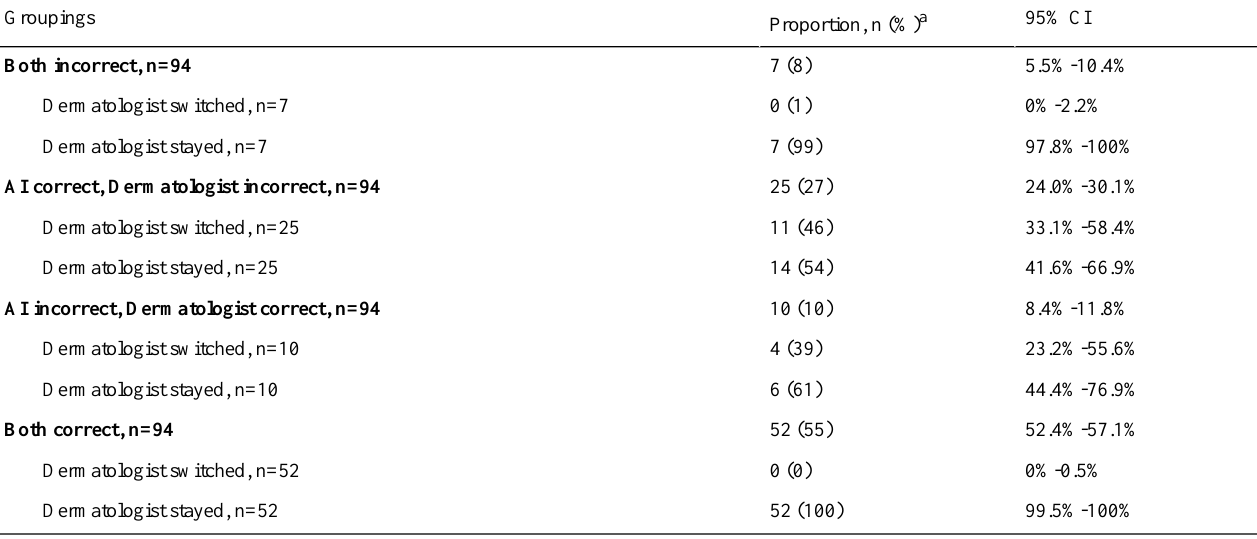
Table 2. Distribution of the correct and incorrect predictions by classifier and dermatologists without artificial intelligence (AI) support and switching in response to AI support. Percentages displayed below show the amount of times a switch did or did not occur for dermatologists when answering part II of the